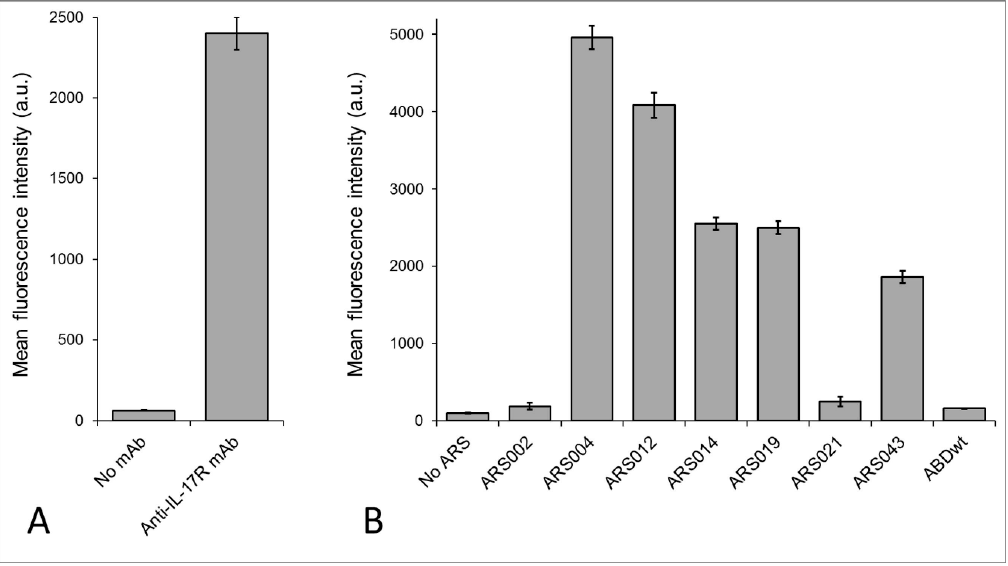
Figure 5. Binding of the ARS variants to human THP-1 cells. ( A ) The expression of IL-17RA on the surface of THP-1 cells was confirmed by anti-IL-17RA antibody. ( B ) For binding assay, 2.5 × 10 5 THP-1 cells were incubated with in vivo biotinylated His 6 -ARS-TolA-AVI proteins or His 6 -ABDwt-TolA-AVI negative control (10 µ g/mL) for 30 min at 4 ◦ C. The cell-bound proteins were stained with streptavidin-PE for 30 min at 4 ◦ C and analyzed by flow cytometry. Each bar represents the mean value ± SD of three independent experiments.